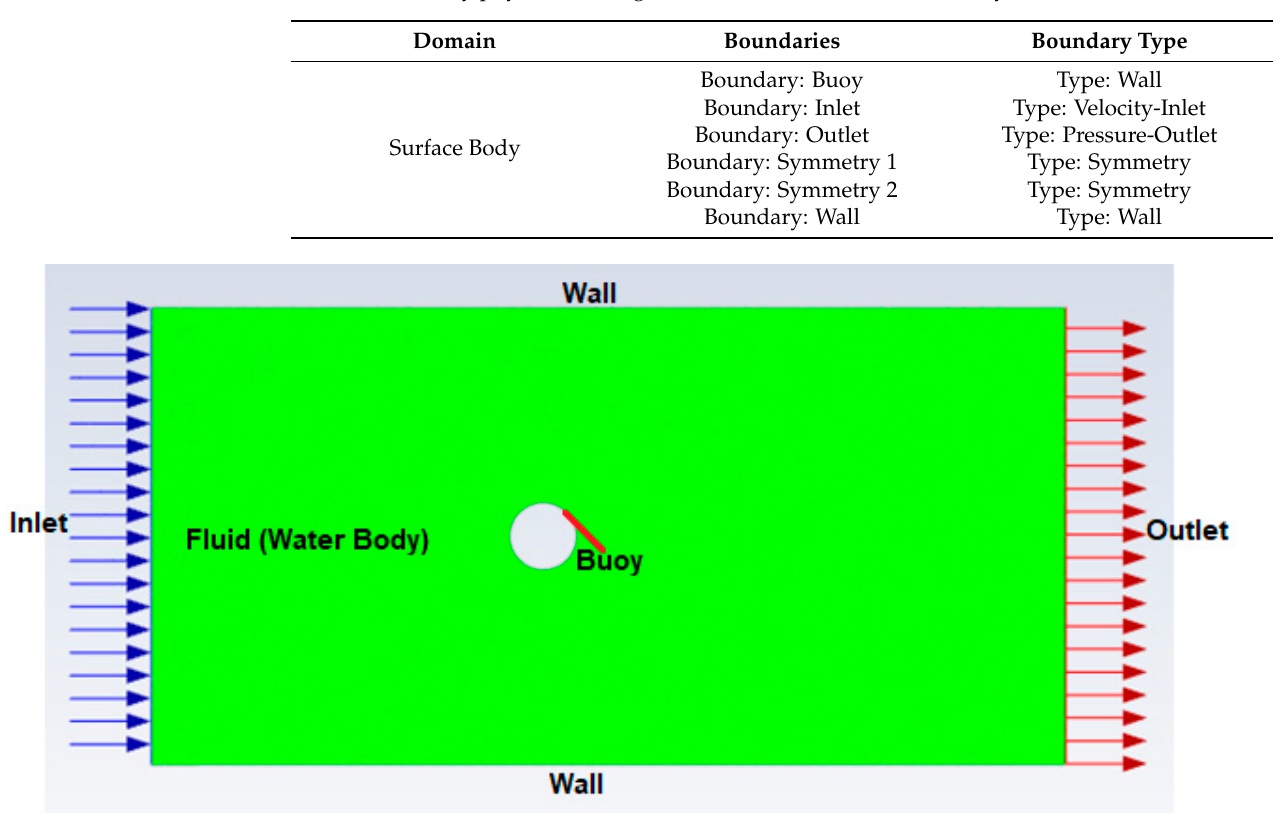
Table 6. Properties of fluid (sea water) used in the FSI model in ANSYS Fluent.